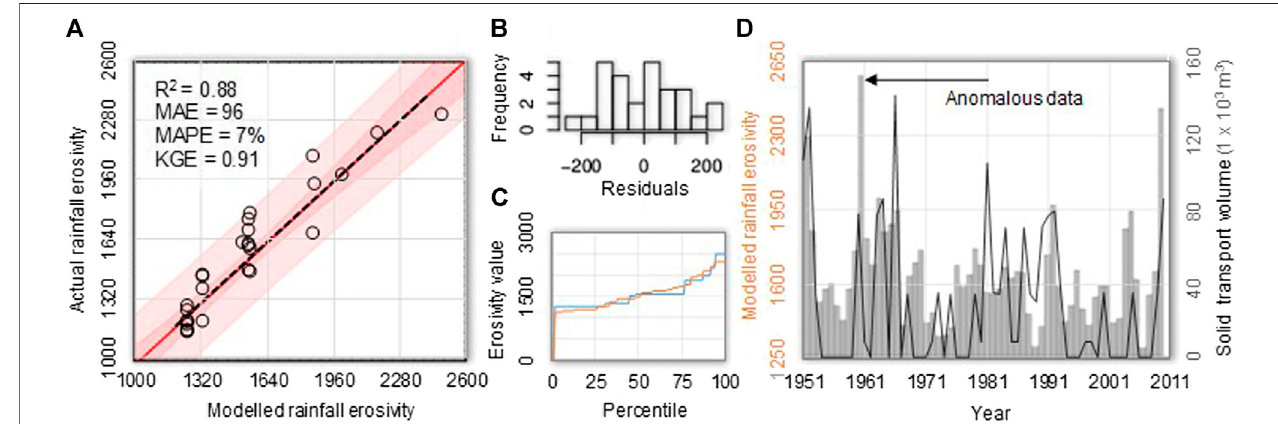
FIGURE 6| Rainfall erosivity model calibration and qualitative validation in the Arno River Basin. (A) Scatterplot (dotted black regression line and red line of identity) of actual vs. modeled — Eq. 2 — rainfall erosivity (MJ mm hm − 2 h − 1 yr − 1 ) for the 1964 – 1990 period, with the inner bounds showing 90% con fi dence limits (power pink colored area), and the outer bounds showing 95% prediction limits for new observations (light pink), (B) histogram of residuals, (C) percentiles of actual (blue curve) and modeled (orange curve) rainfall erosivity, and (D) coevolution of modeled annual rainfall erosivity (black line) and sand transport volumes (grey histogram) at the mouth of the Arno river in the 1951 – 2010 period (from Monti and Rapetti,